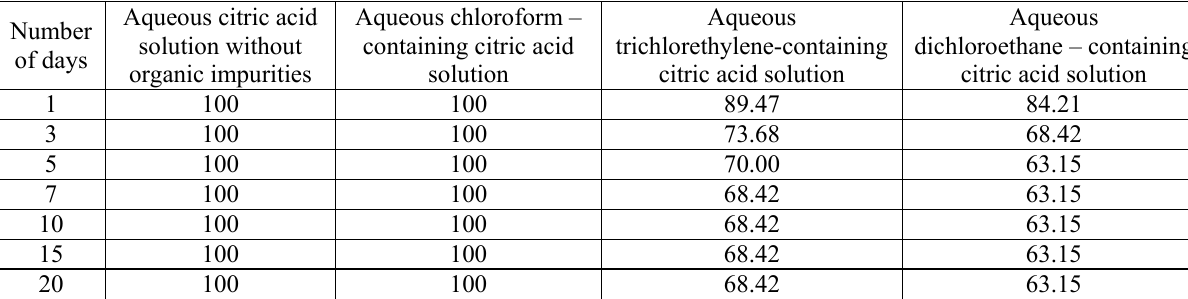
Table 3. Residual content of citric acid in the studied samples during storage, %